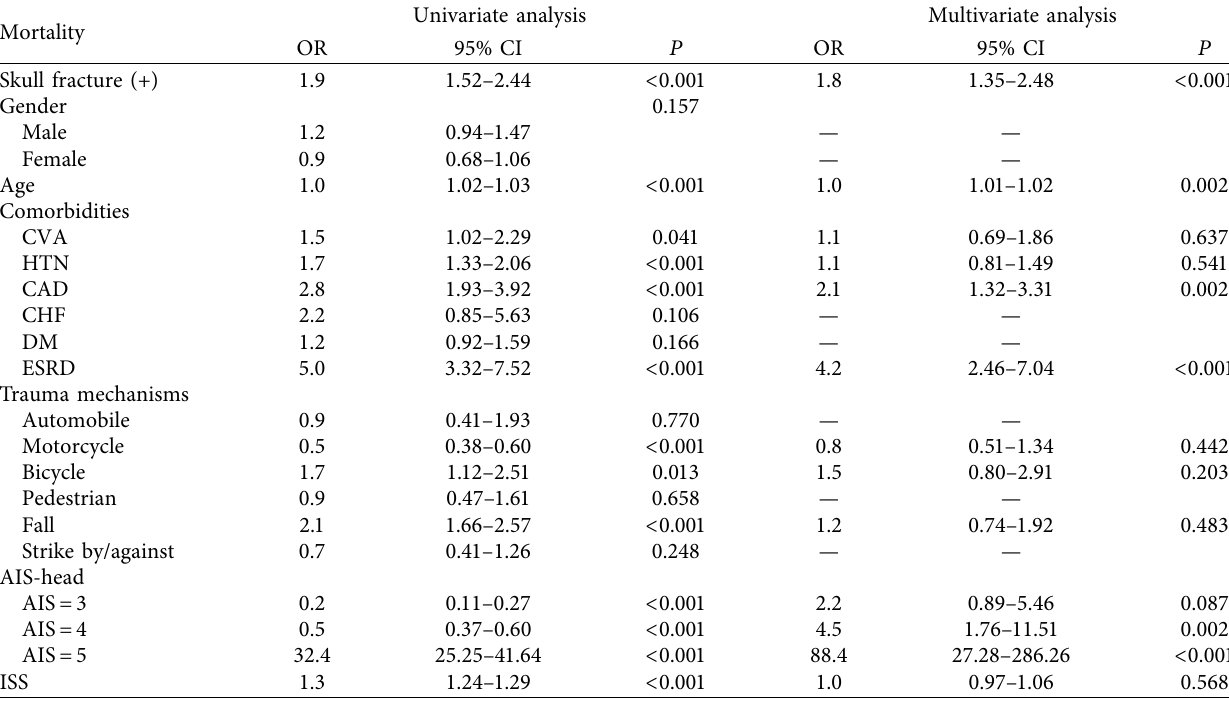
Table 2: Univariate and multivariate logistic regressions of the risk factors for mortality of the patients with traumatic brain injury.